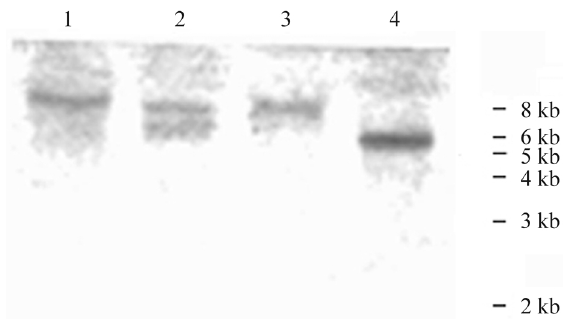
Figure 3 - Southern blotting analysis of genomic DNAs extracted from adult amphioxus B. belcheri tsingtauense . The digoxigenin